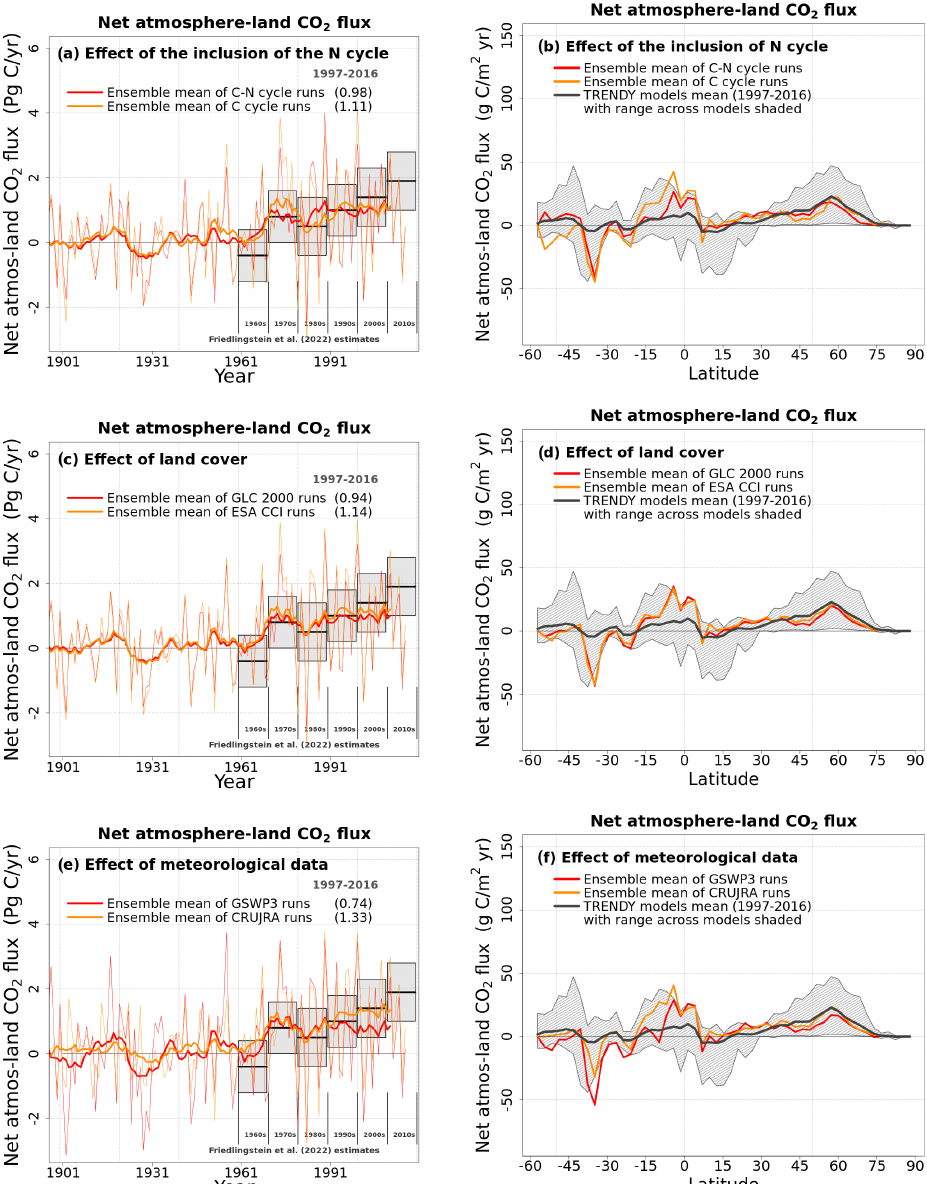
Figure 9. Time series of global net atmosphere–land CO 2 flux (over all land area excluding Greenland and Antarctica) (a, c, e) and its zonally averaged values (b, d, f) averaged, for the period 1997–2016, over the four ensemble members that are driven with and without an interactive N cycle (a, b) , that are driven with the GLC-2000- and ESA-CCI-based land cover representations (c, d) , and that are driven with GSWP3 and CRU-JRA meteorological data (e, f) . The thin lines for the time series show the individual years, and the thick lines show their 11-year moving average. Model values averaged over the pre-industrial (1851–1860) and present-day (1997–2016) time periods, and their difference, are also shown for panels (a) , (c) , and (e)